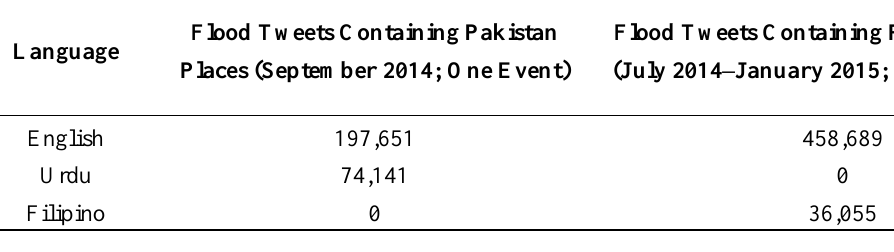
Table 2. Filtered flood-related tweets between 1 September 2014 and 31 January